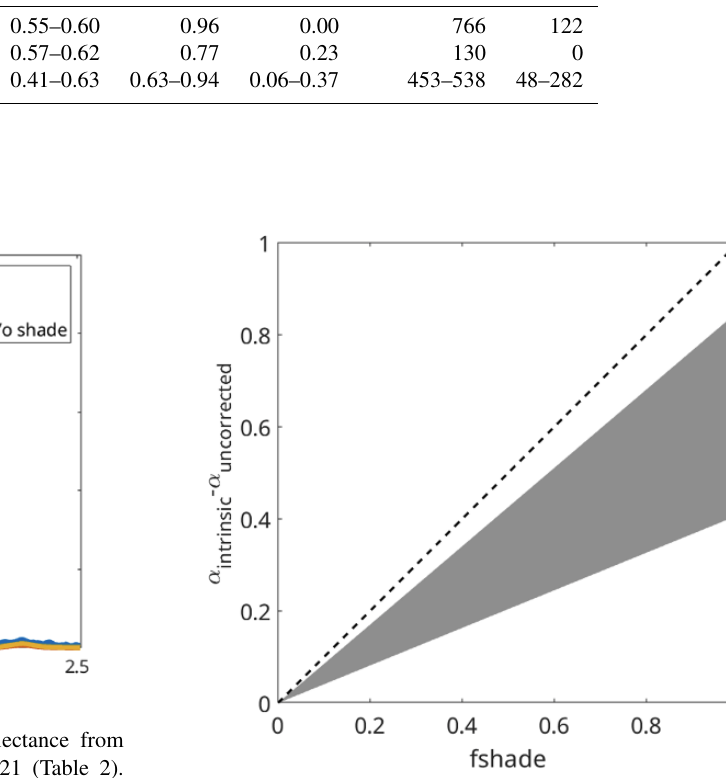
Figure 10. Difference between intrinsic and apparent albedo ver- sus shade fraction. The gray area represents the range of radiative transfer solutions using different combinations of grain sizes, solar zenith angles, and